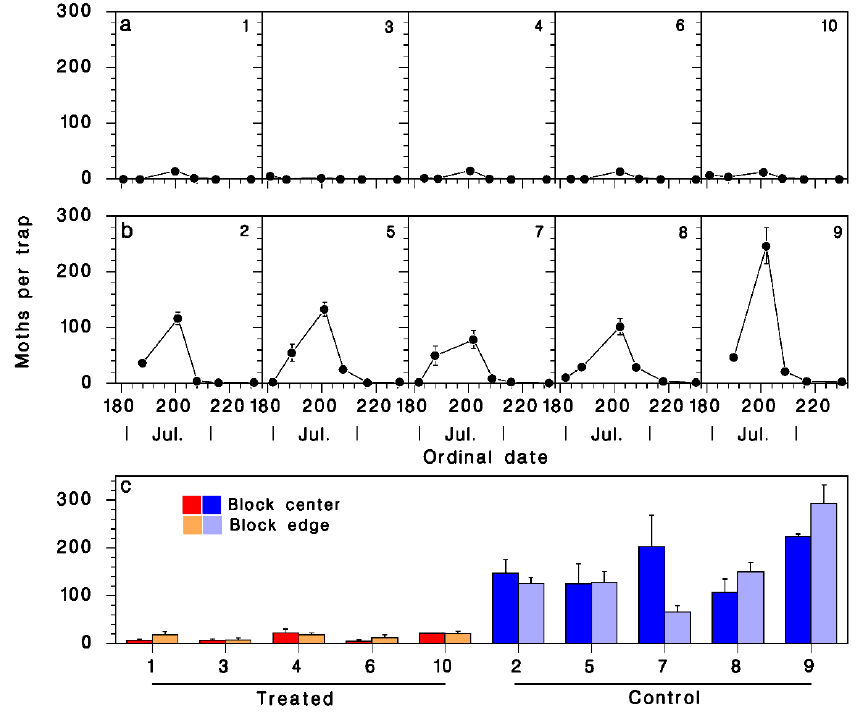
Figure 5. Mean ( ± SEM) adult SBW catch in pheromone traps. ( a ) In treated and ( b ) untreated blocks between June 30 and August 19, 2021. Block numbers in top right corners of panels. ( c ) Trap catch in center and at edges of blocks (Red: treated; blue: controls; dark: center; pale: edge). Table 2. GLM analysis of total capture in pheromone traps in each cluster after a normalizing Box-Cox